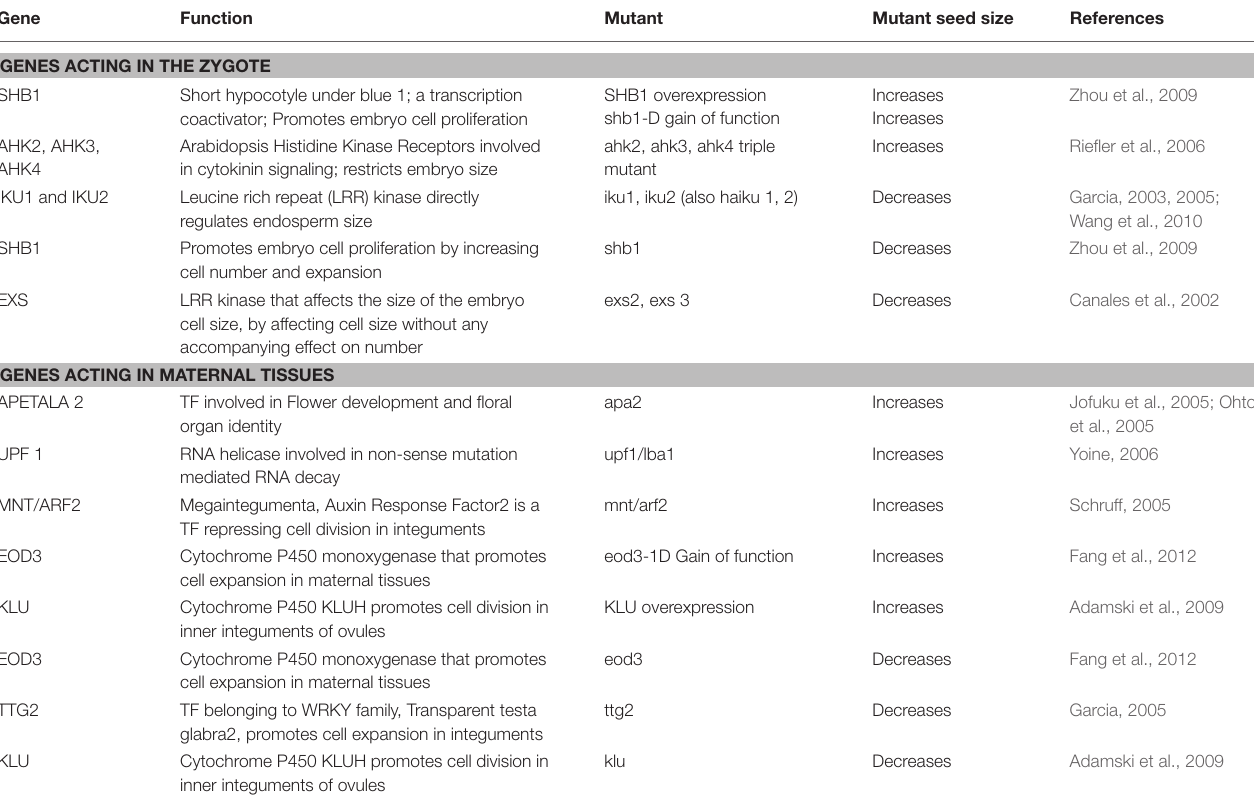
TABLE 1 | Maternal and zygotic (genetic) controls on seed size: Insights from Arabidopsis thaliana .